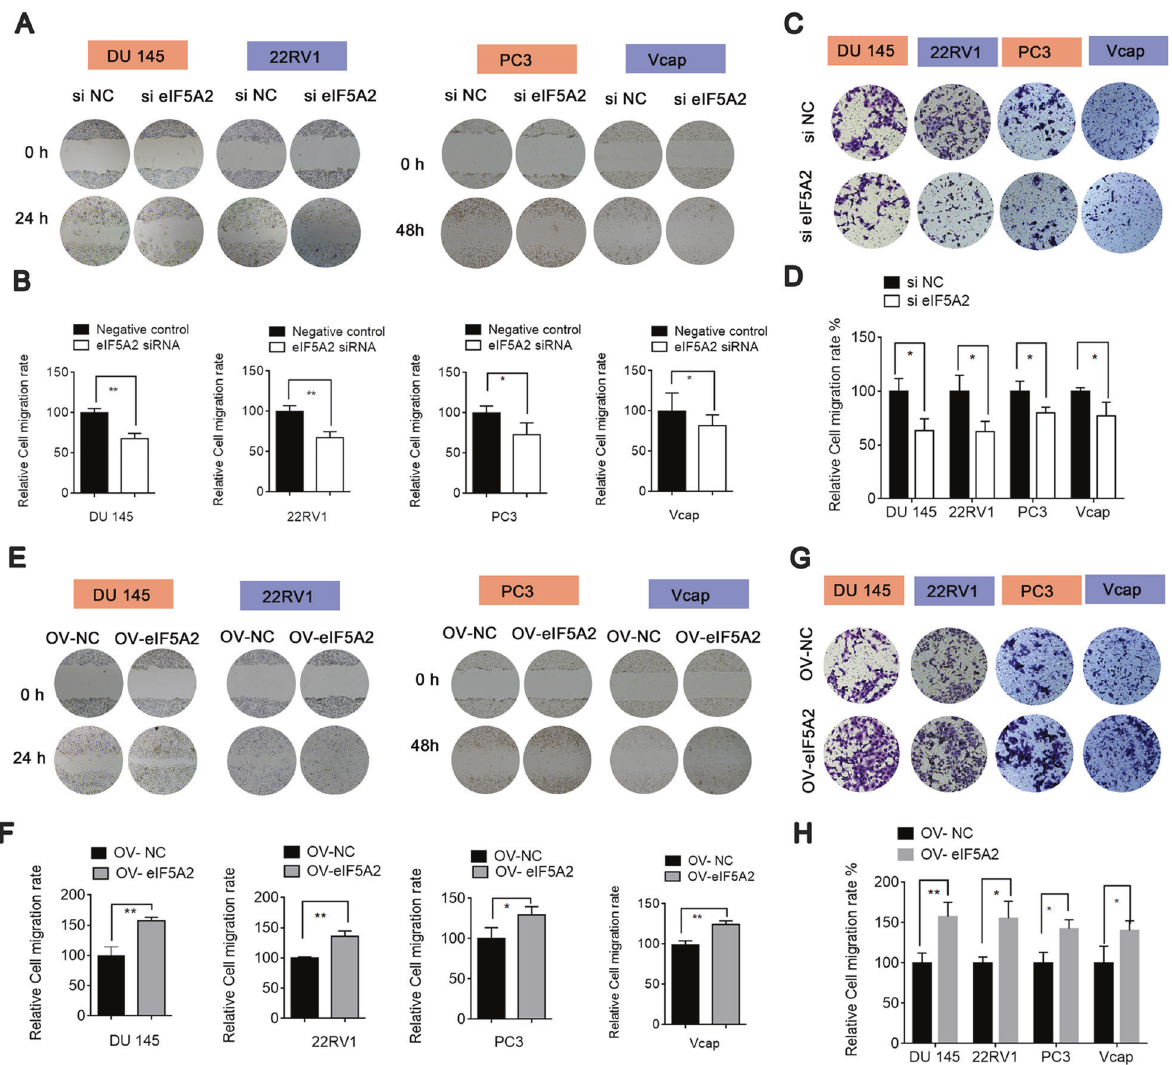
Fig. 2 Effect of eIF5A2 on PCa cell migration and invasion. A , B Migration of DU145 and 22RV1 cells transfected with eIF5A2 siRNA or negative siRNA. C , D Invasion of PCa cells transfected with eIF5A2 siRNA or negative siRNA. E – H Migration and invasion of PCa cells transfected with eIF5A2 plasmid or negative plasmid. (* P < 0.05, ** P < 0.01 versus negative control or plasmid